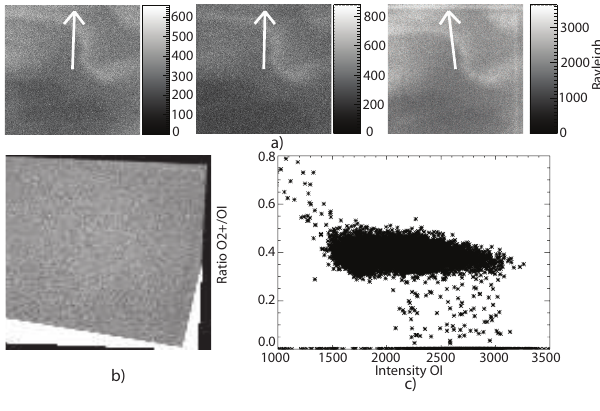
Fig. 10. Same format as Fig. 9, for images taken at 21:14:14,500 on 2 January 2006.